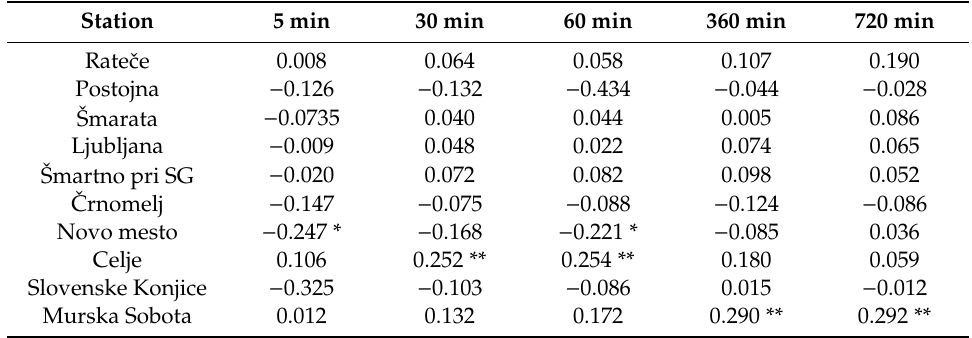
Table 2. Mann-Kendall test results for the AM sample. * and ** indicate statistically significant test result (with the 0.05 significance level) that is negative and positive, respectively.